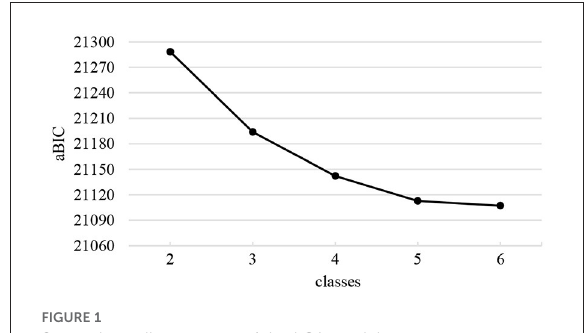
FIGURE1 Steep slope diagram test of the LCA